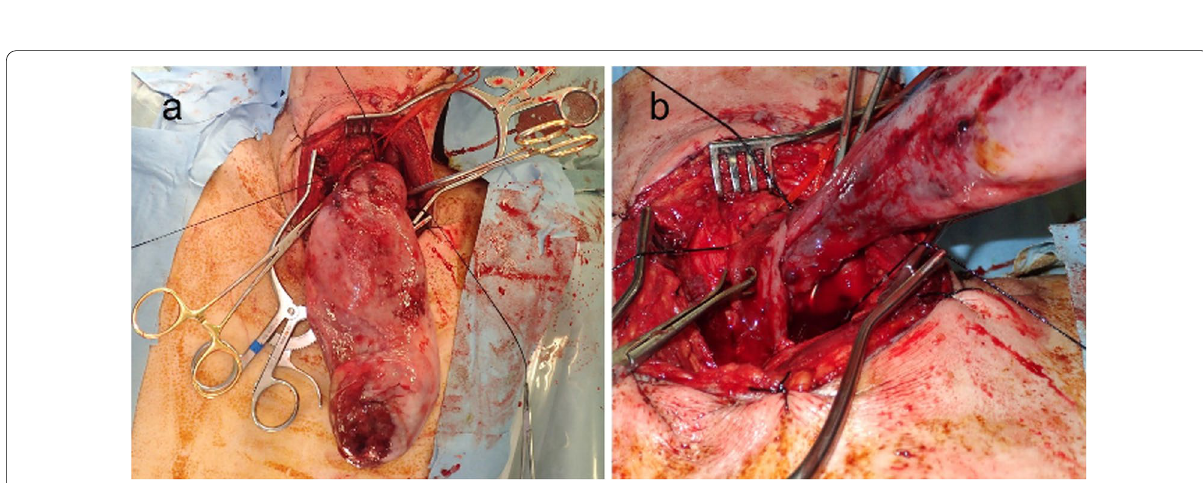
Fig. 3 Intraoperative view. a A 7-cm skin incision was made on the left side of the neck. The giant tumor was directly grasped and carefully pulled out of the esophageal lumen. b The stalk of the tumor arising from the posterior wall was transected and the tumor was